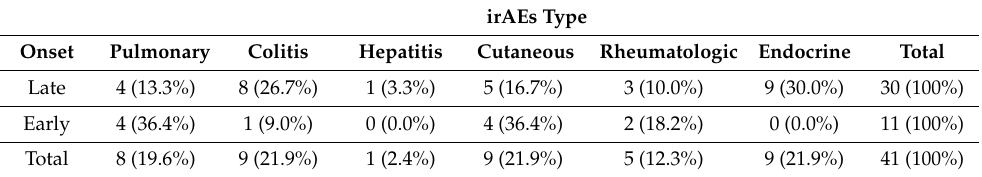
Table 3. Type of irAEs divided by onset